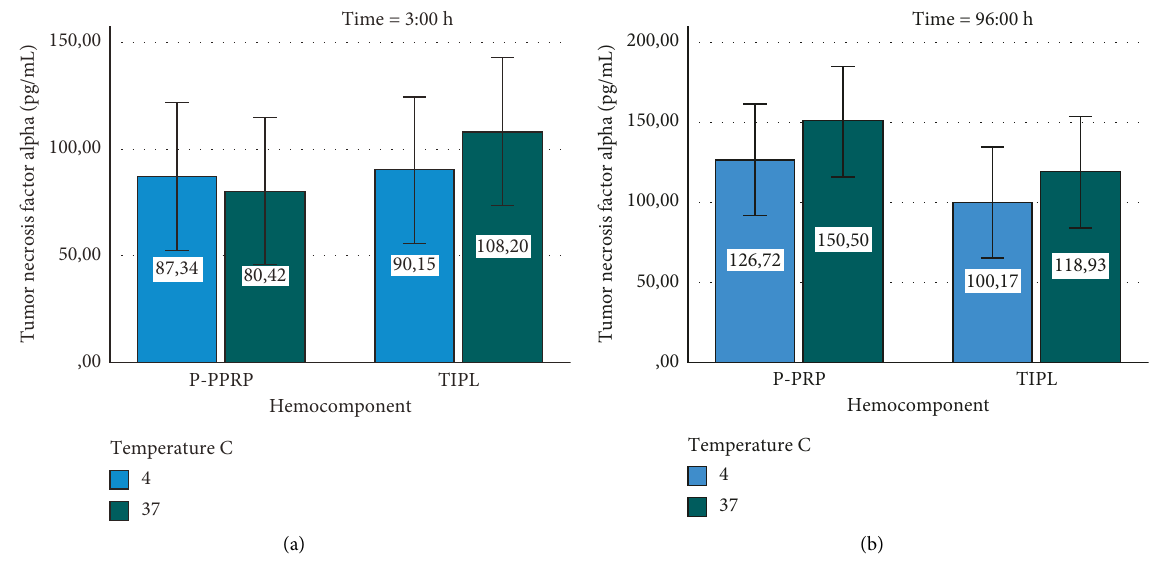
Figure 7: Mean ± sd tumor necrosis factor alpha concentration in hemocomponents affected by time and temperature. (a) Tumor necrosis factor alpha at 3h. (b) Tumor necrosis factor alpha at